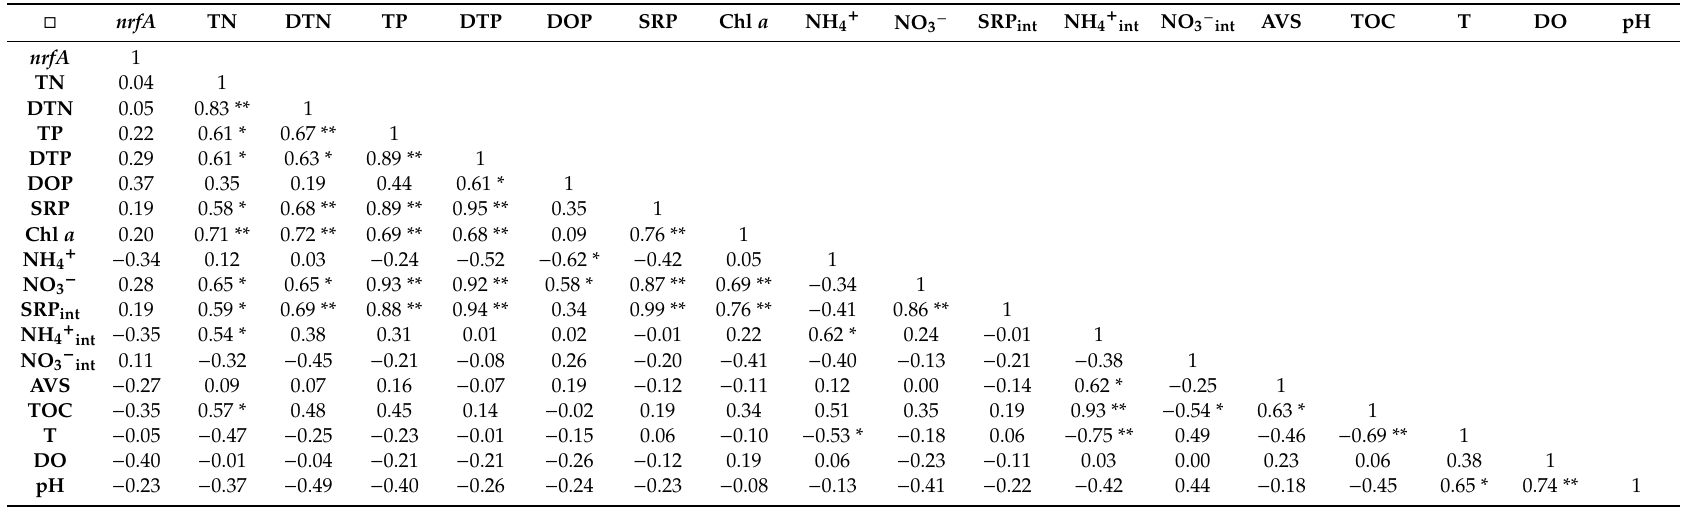
Table 2. Pearson’s correlation coe ffi cients among di ff erent parameters in Lake Qingling, Lake Zhiyin, and Lake